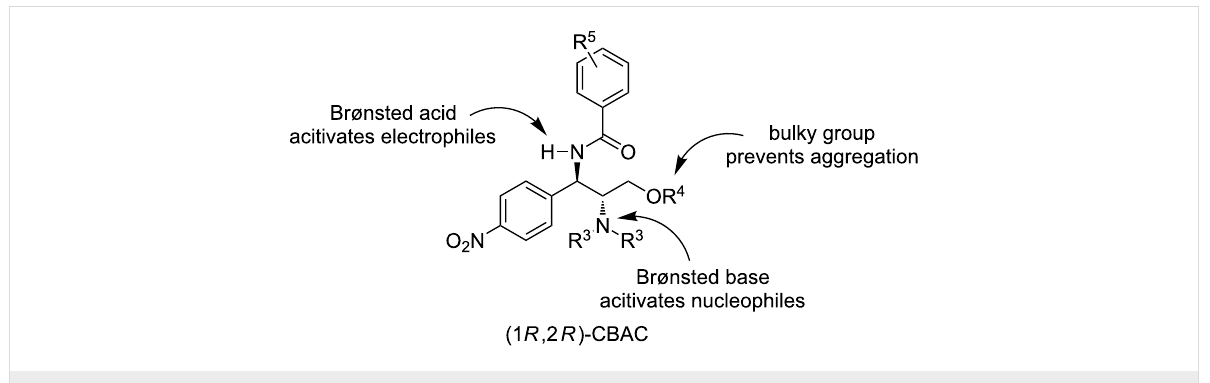
Figure 2: Design of new chloramphenicol base amide organocatalysts.